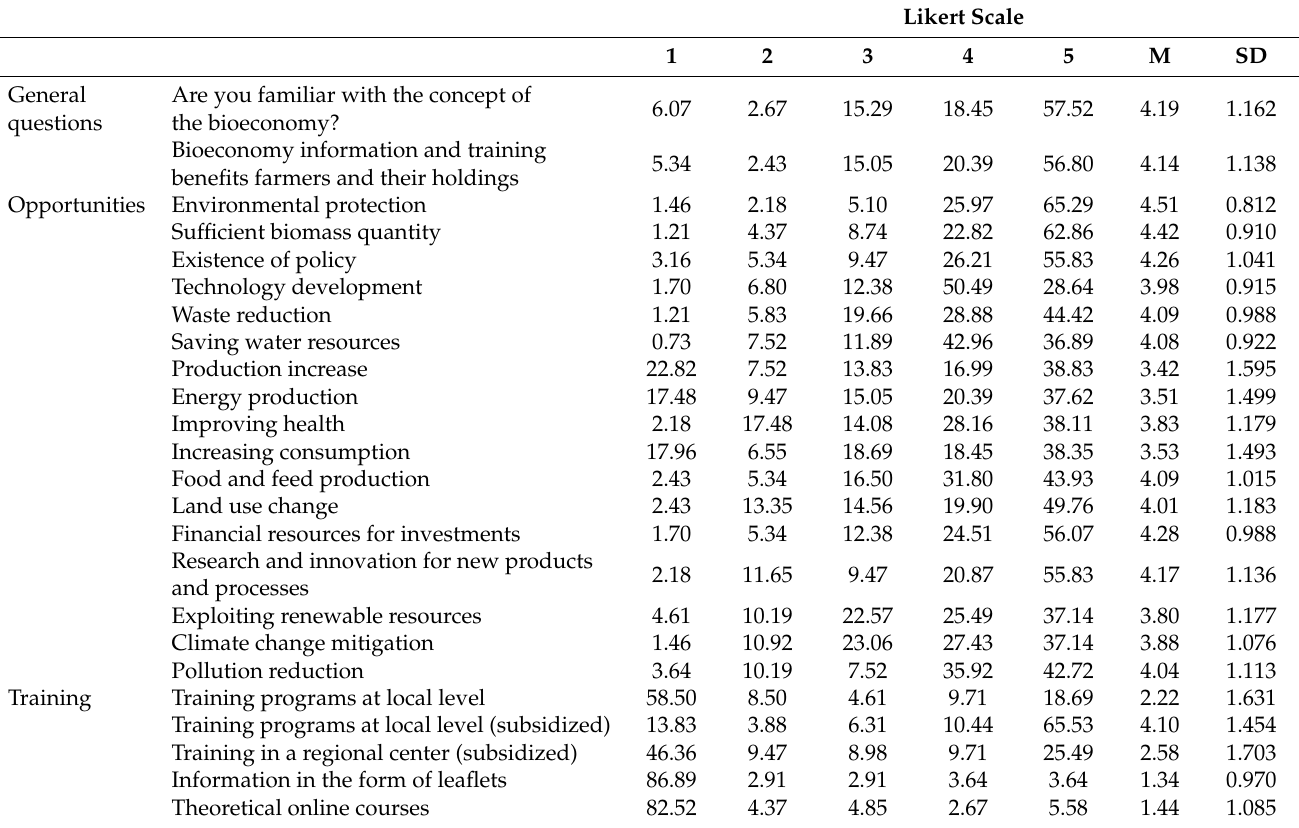
Table 2. Total responses to 2 general questions and 22 questions on opportunities and training in respect of the